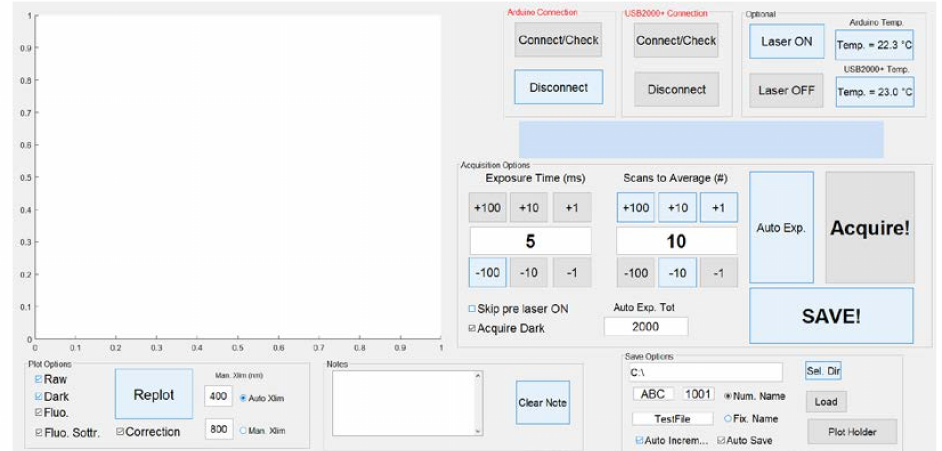
Figure 2. SFIDA–405 graphical user interface.